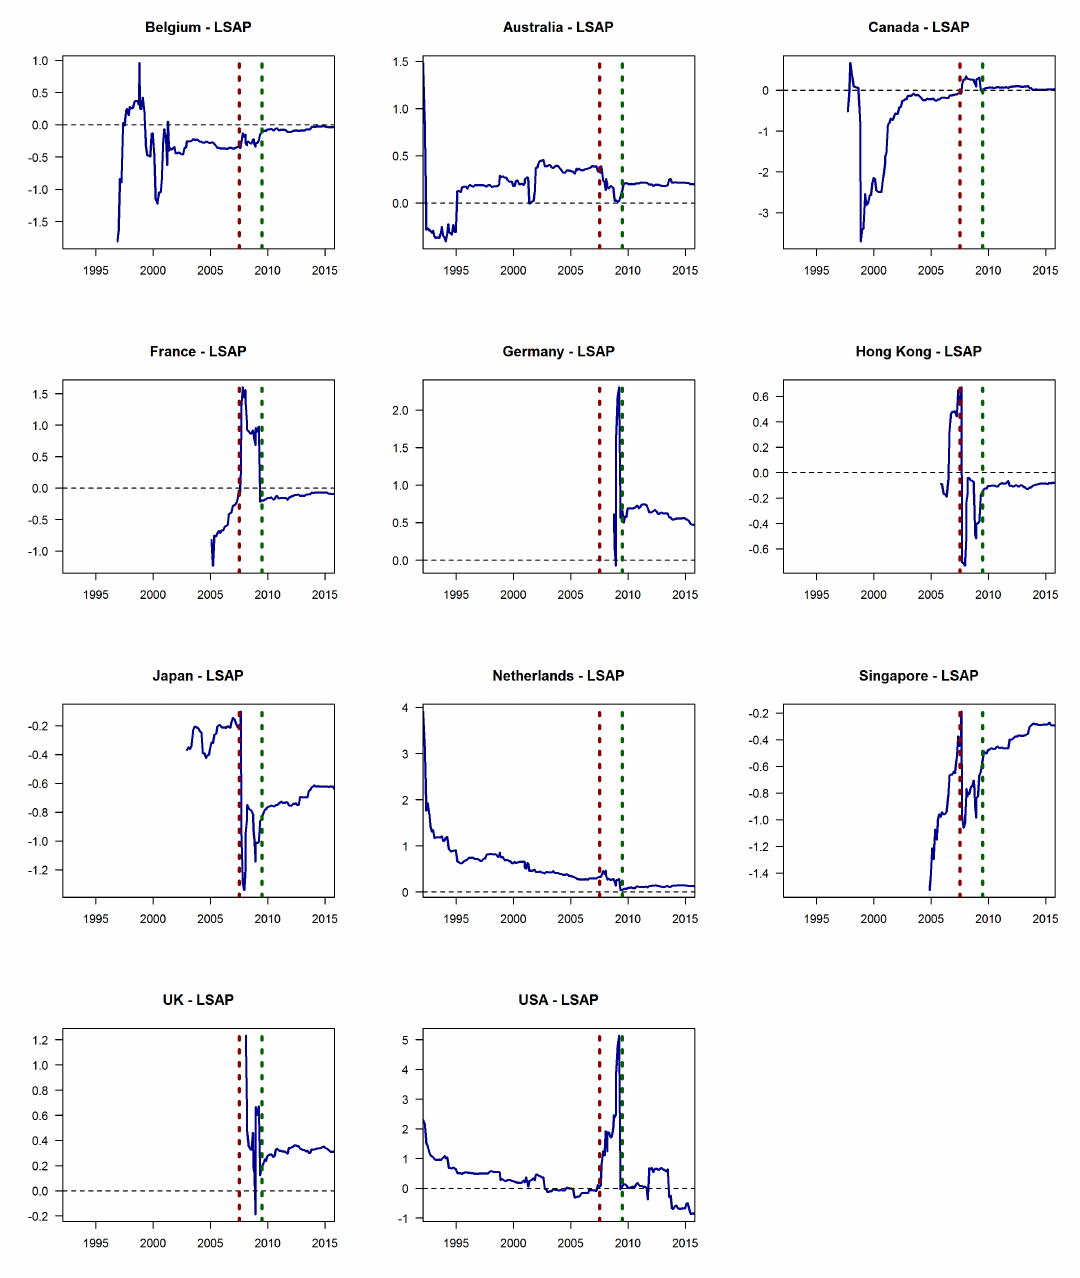
Figure 3. Time-varying impact of LSAP shocks. The plots show the time-varying response of international REITs to LSAP shocks. he period between the two vertical dotted lines capture the period of global financial